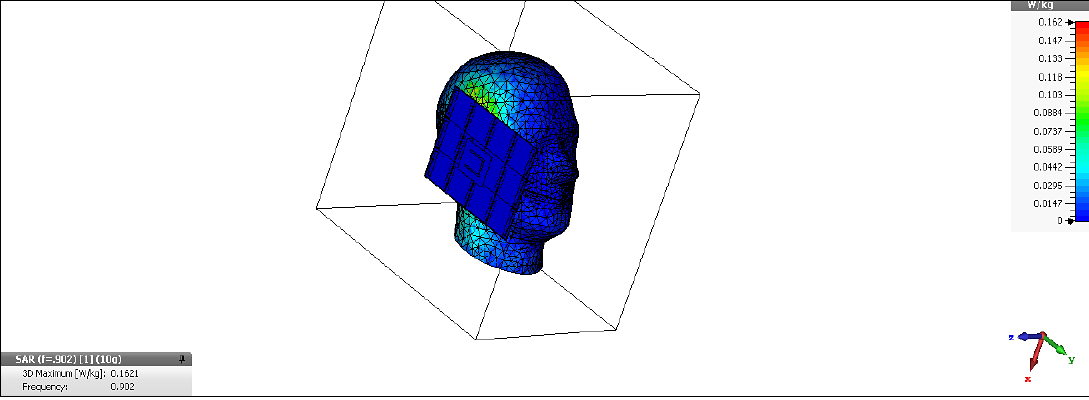
Figure 23. Power distribution after adding SRRs